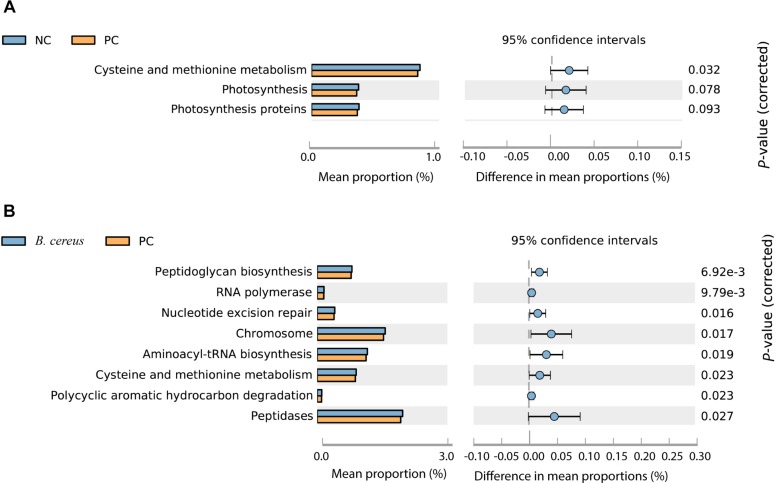
Predicted metabolic functions at KEGG level 3. NC, negative control; PC, positive control. (A) The comparison between the NC and PC group. (B) The comparison between the PC and B. cereus group.